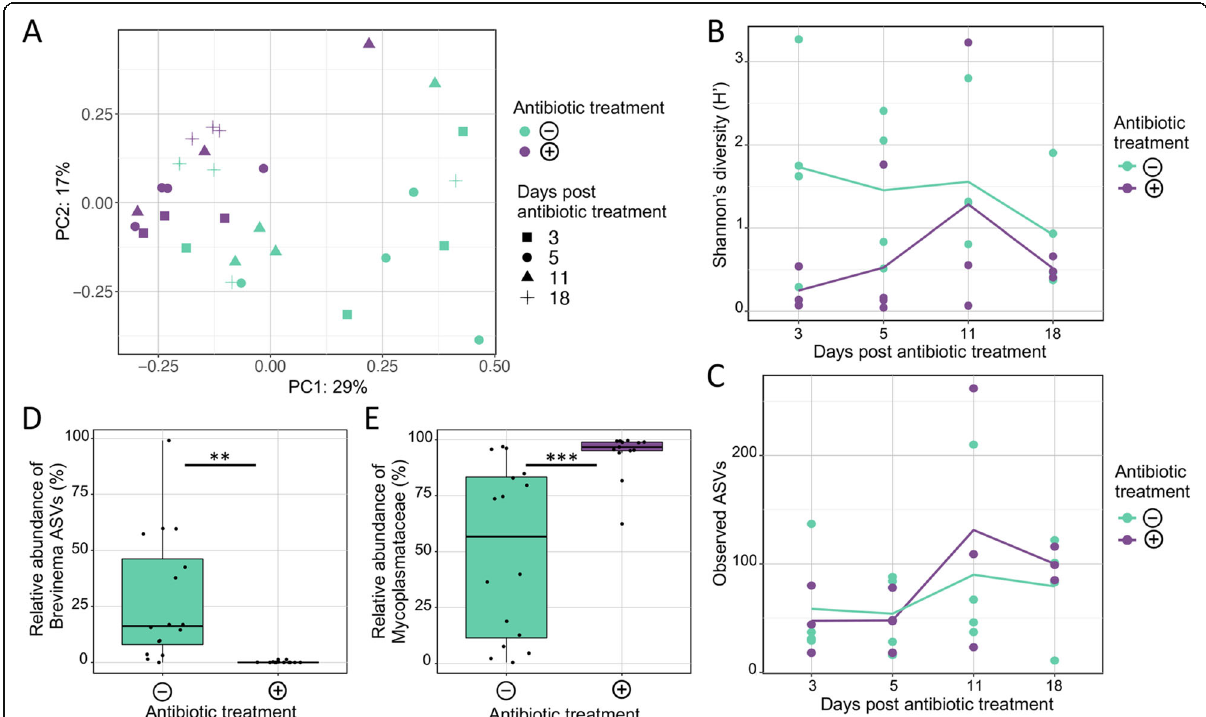
Fig. 3 Effect of antibiotics on the gut microbiota of yellowtail kingfish. a PCoA plot representing Bray-Curtis similarities comparing the change in global gut bacterial assemblages after treatment with antibiotics (+) over 18-days, with those fish that did not receive treatment ( − ). b - c Means plots showing the change in mean value of Shannon ’ s index of diversity and total observed ASVs (as a measure of richness), respectively, over the 18-day treatment period (from n = 4 fish). d - e Boxplots presenting the median and IQR of the relative abundances of the summed Brevinema - associated ASVs and a single ASV associated with Mycoplasmataceae (ASV1452), respectively, comparing fish treated and not treated with antibiotics. The level of significant difference is denoted by * p ≤ 0.05, ** p ≤ 0.01 or *** p ≤ 0.001, following the Mann-Whitney U